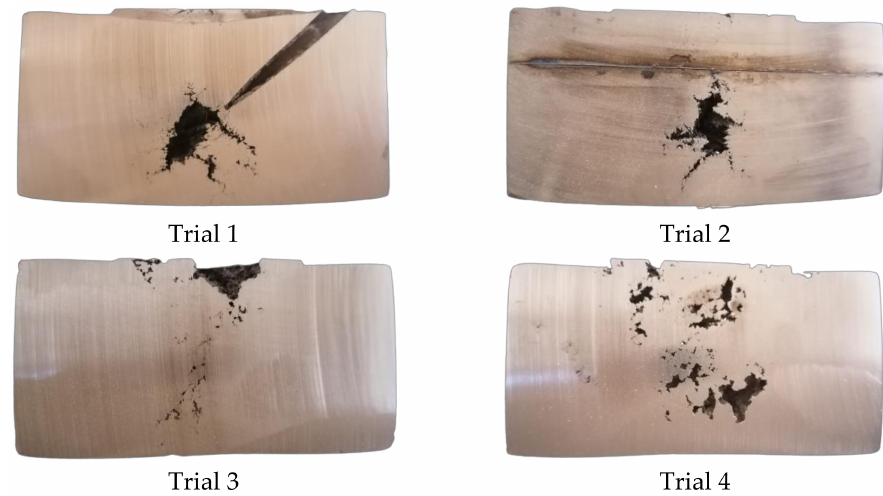
Figure 20. Visual inspection of the part, trial 1 to 4 (cross-section cut).